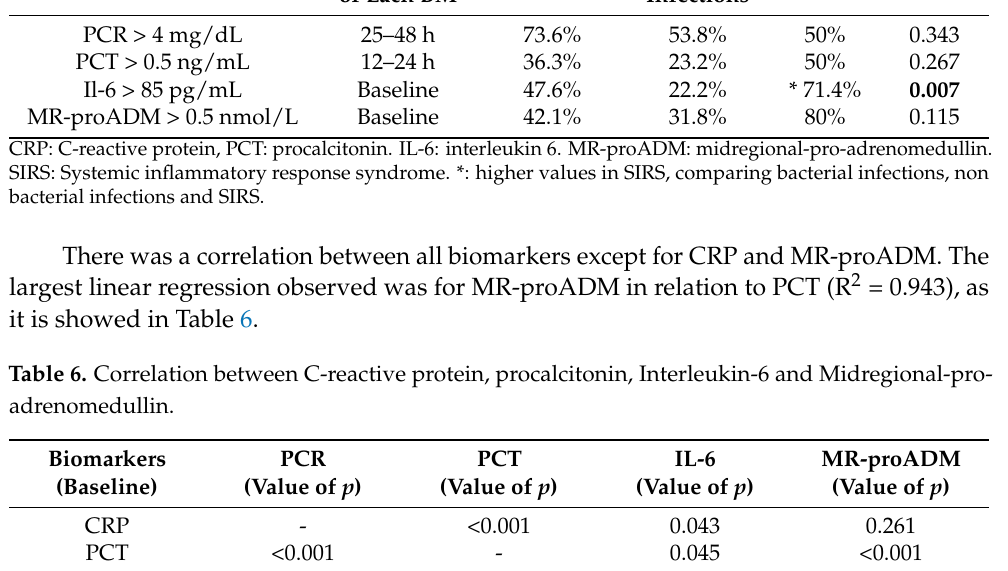
Highest Non Bacterial Level Point Bacterial Infections of Each BM